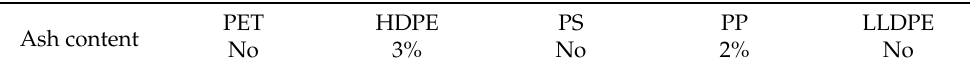
Table 1. Ash content of different plastics [19,20]. Ash